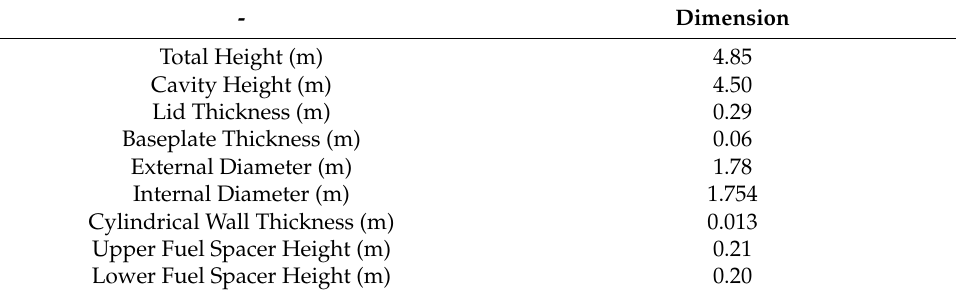
Table 2. The MPC-32 main dimensions [25].